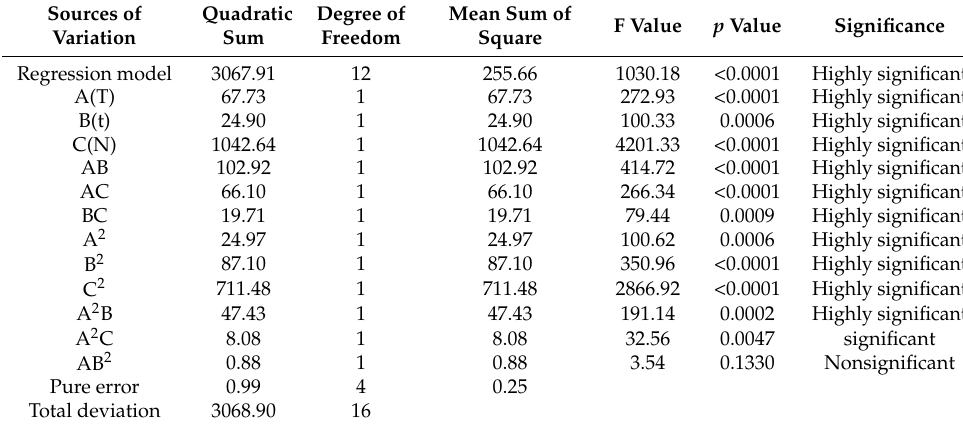
Table 3. Regression analysis results of the Cd removal